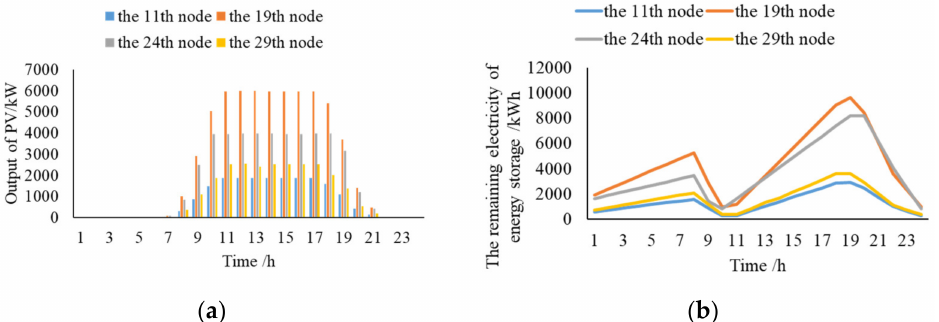
Table 1. Under the principle of equal PV electricity curtailment ratio, the distributed PV